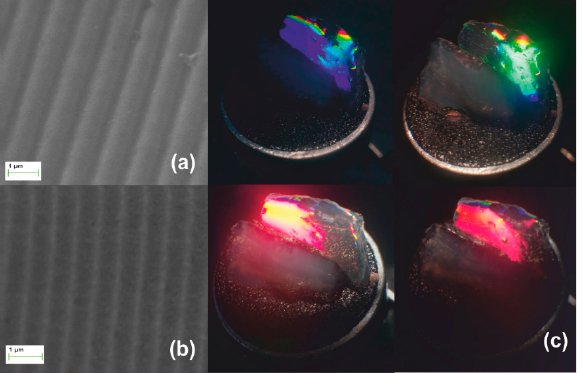
Figure 2. SEM micrographs of: ( a ) polymer master surface relief holographic grating of period Λ o = 1 μ m; and ( b ) its replica imprinted on the aerogel surface has period Λ aero ~750 nm. Structural coloration by white light diffraction off the aerogel grating is observed at different angles ( c ). In Figure 3a, the original aerogel surface relief grating structure having period Λ aero ~750 nm is depicted for comparison to its miniaturized replica of period Λ aero-I ~280 nm in Figure 3b.